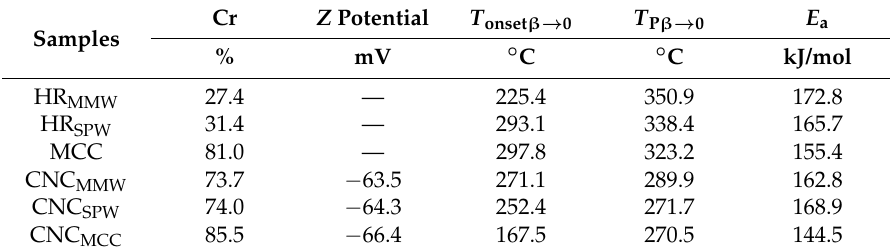
Figure 4. Flow birefringence of cellulose nanocrystal suspensions between two cross polarizers ( a ) CNC MMW , ( b ) CNC SPW , and ( c ) CNC MCC .